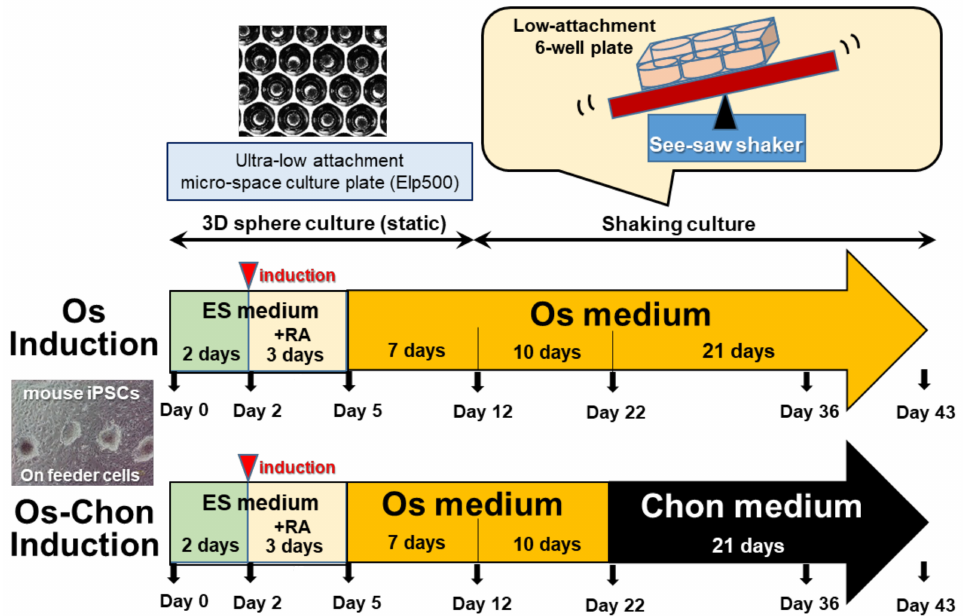
Figure 6. Schematic diagram of the culture protocol for Os and Os-Chon induction of iPSCs (see text for